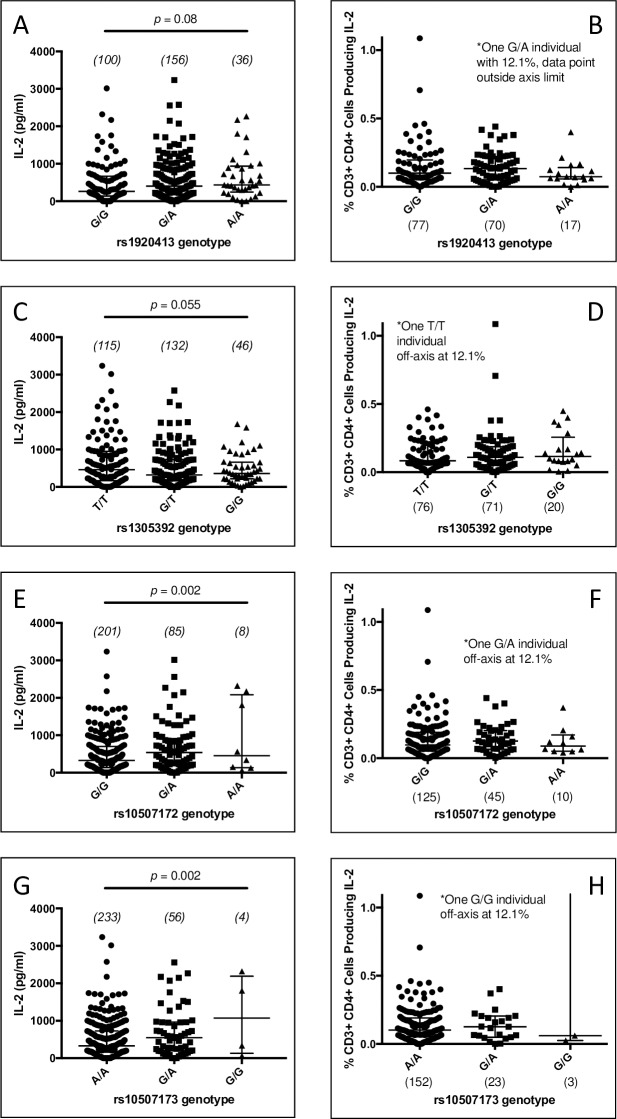
BCG-induced whole blood and intracellular cytokines.Blood drawn from 10-week old infants was stimulated ex-vivo with BCG. For whole-blood secreted cytokines, (A, C, E, G), IL-2 and IFN- γ supernatant levels were measured by enzyme-linked immunosorbent assay. Median and interquartile ranges of stimulated (BCG) minus unstimulated levels are shown for selected SNPs (with p-values calculated by a generalized linear model). Genotype frequencies are provided in parentheses above each genotype. For intracellular cytokine assays (B, D, F, H), an independent sample set was stimulated with BCG as above and brefeldin A added 7 hours later. Samples were evaluated using flow cytometry for cell surface markers and for intracellular cytokines IL-2 and IFN- γ. Median and interquartile ranges are shown for CD4+ T-cells for select SNPs. Genotype frequencies are provided in parentheses below each genotype. H: p = 0.0001 (analysis of variance (ANOVA))), p = 0.59 without outlier. p-values nonsignificant for B, D, and H (ANOVA).